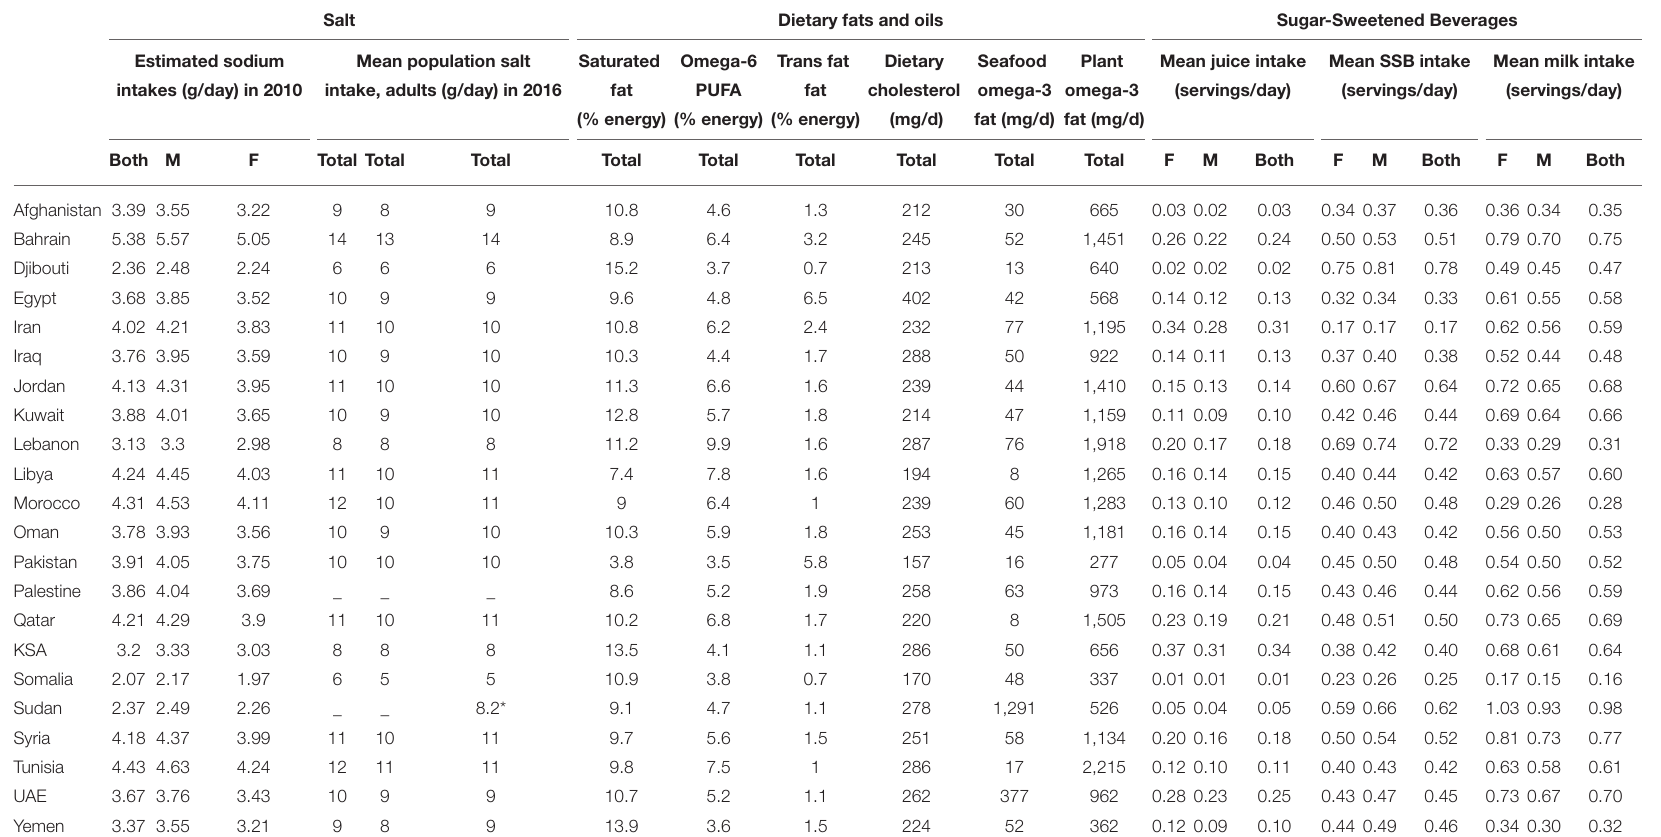
TABLE 4 | Salt, fat, and sugar-sweetened beverage consumption in EMR (4, 11, 12,